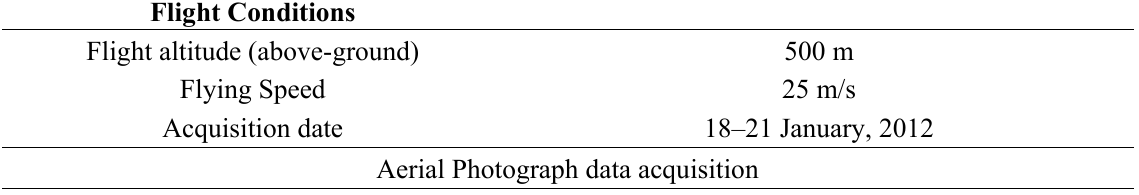
Table 2. Details of aerial photograph data and airborne light detection and ranging (LiDAR) data